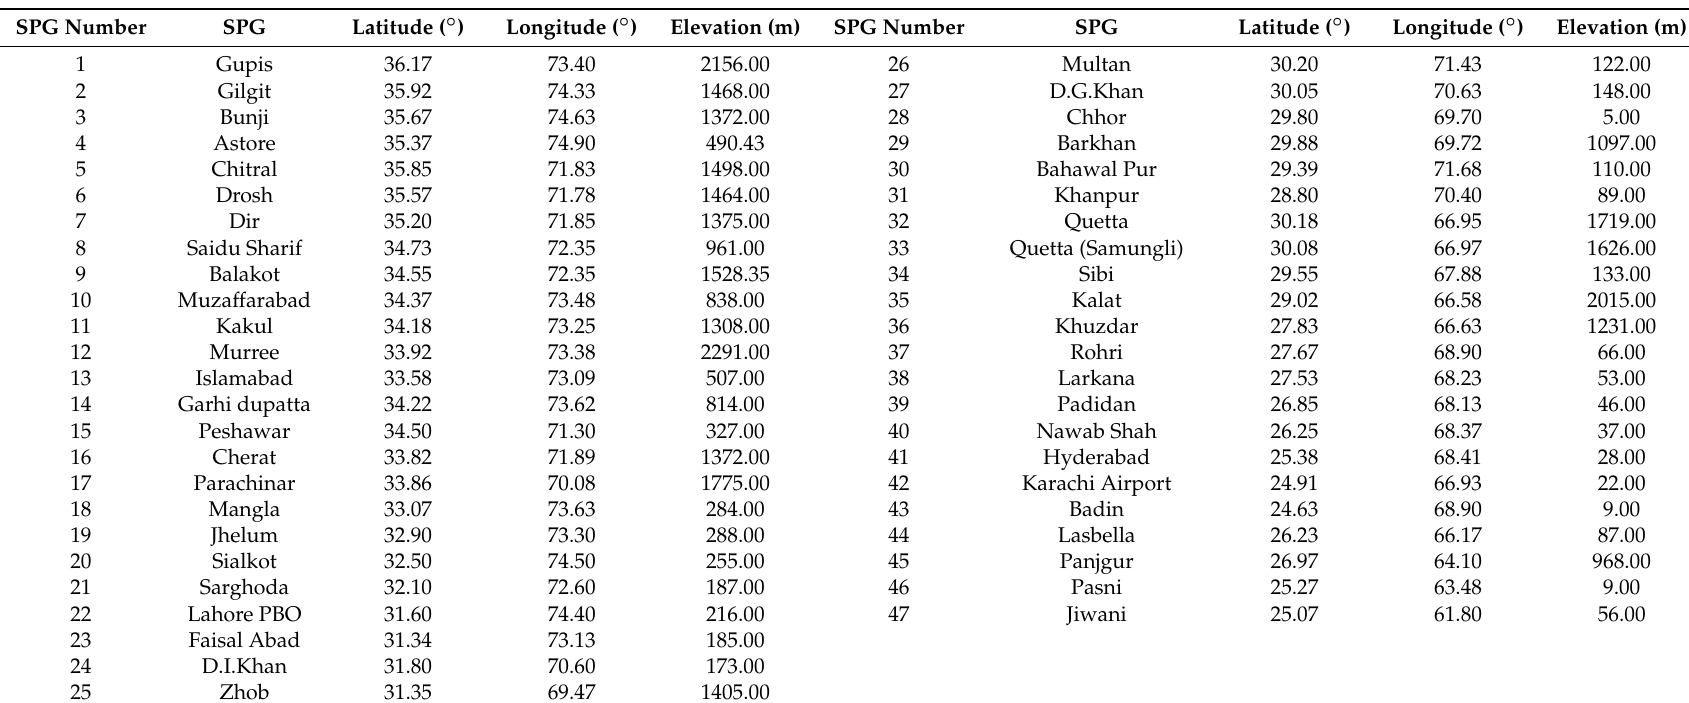
Table 1. PMD SPGs used in the study along with SPG number (shown in Figure 1b), Latitude (N), Longitude (E), and Elevation